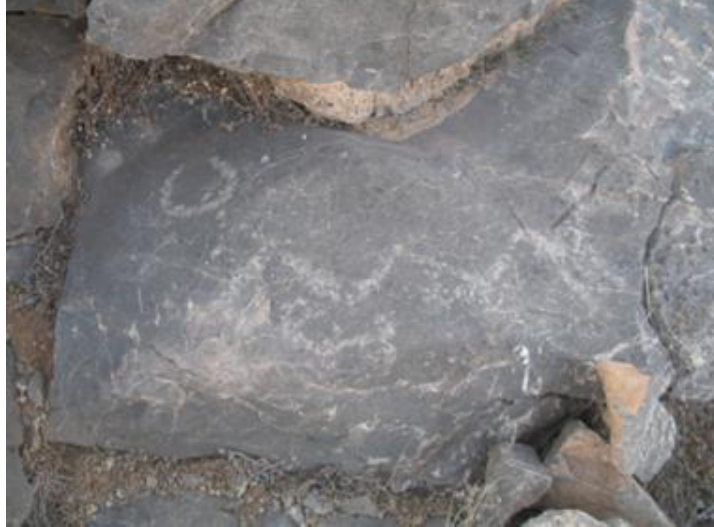
Figure 8. Ghārā-Tepe I, panel 5, geometric